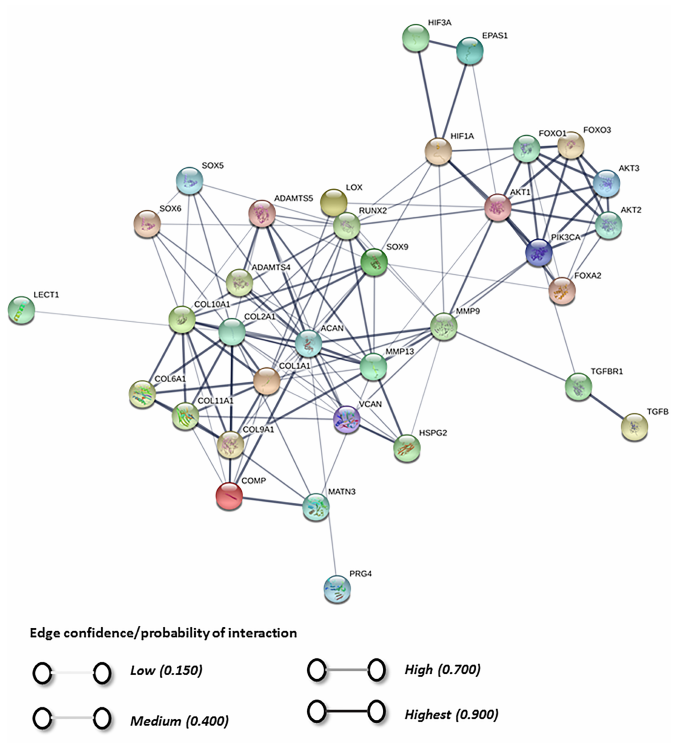
Figure 5. STRING database analysis based upon genes and proteins under the influence of physioxia and chondrogenesis, which describes the probability of interactions between